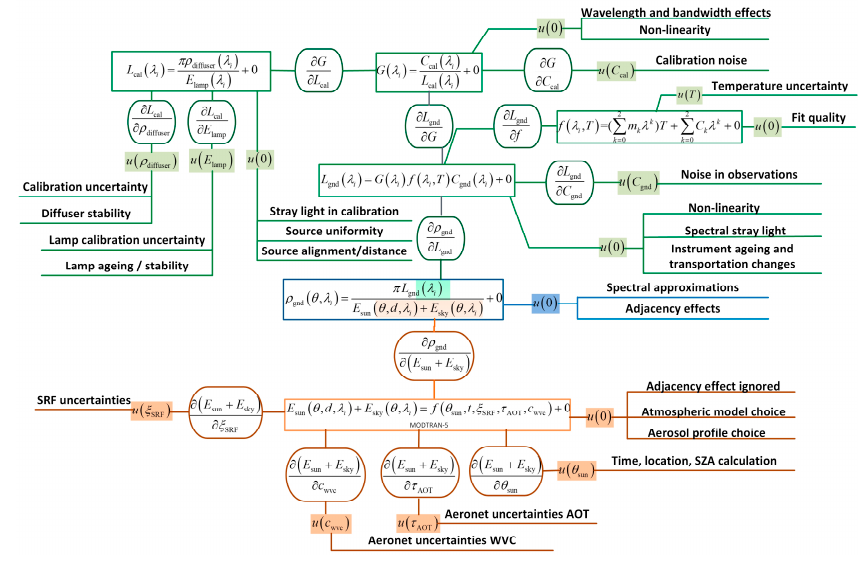
Figure 4. Uncertainty tree diagram for the Baotou measurements of ground spectral